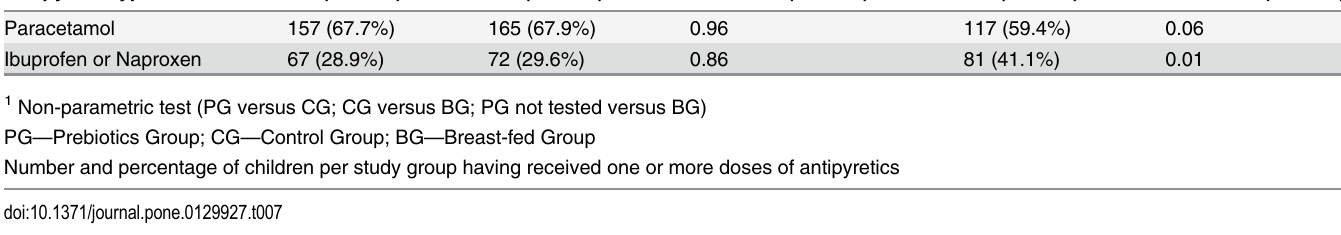
Table 7. Use of antipyretics from third to fifth birthday. Antipyretic type